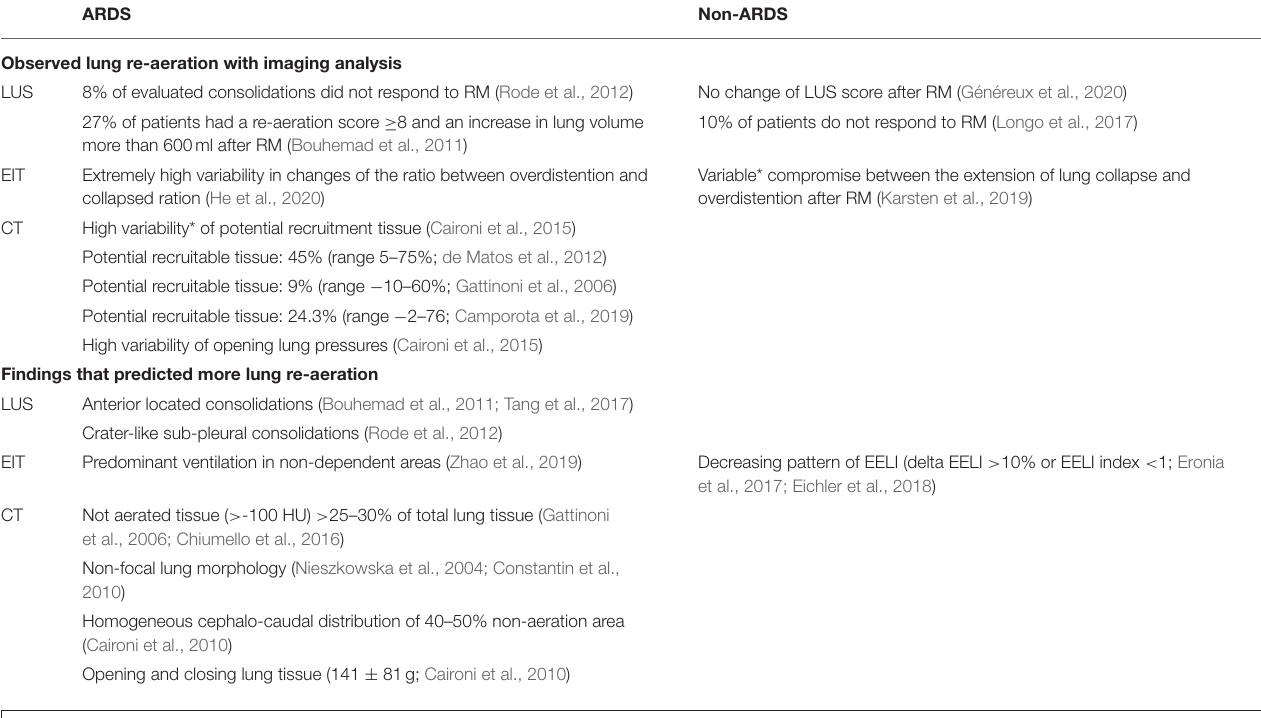
TABLE 3 | Observed recruitment maneuver re-aeration effect and findings related to potential for lung re-aeration after recruitment maneuver according to the imaging module and the presence or not ARDS. ARDS Non-ARDS